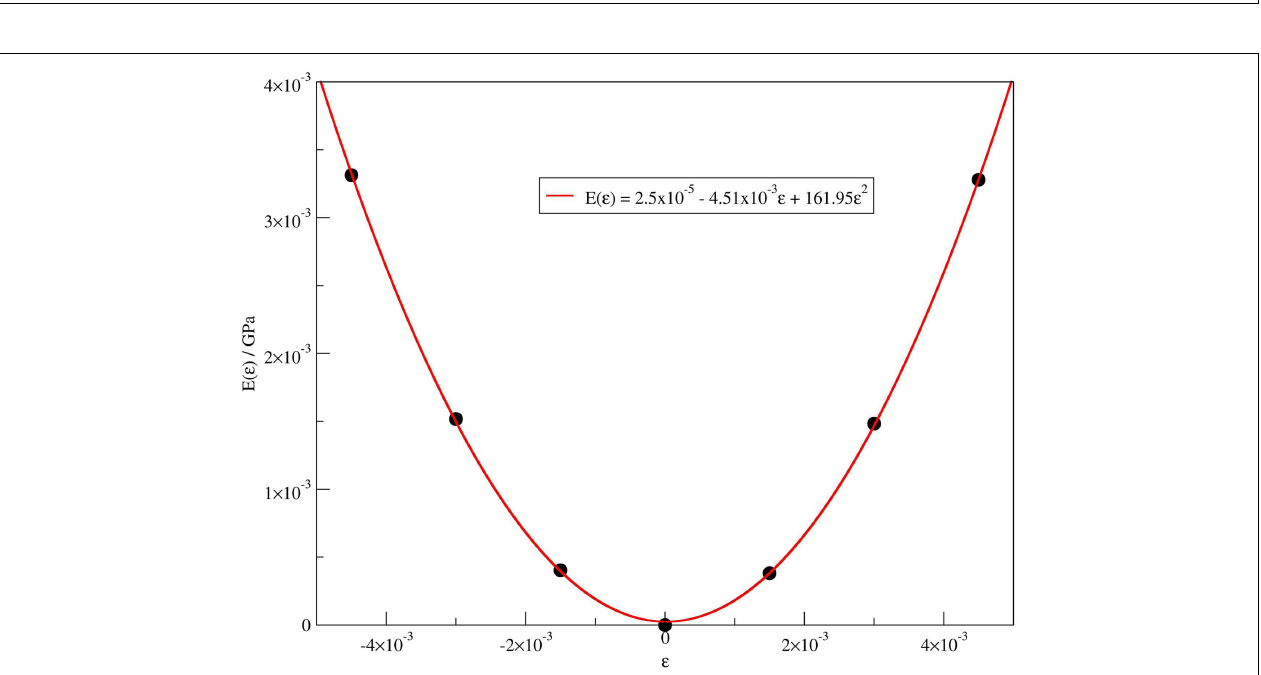
FIGURE 3 | Polynomial quadratic fit to the energy vs. strain data for imogolite (12,0) and fitted equation .